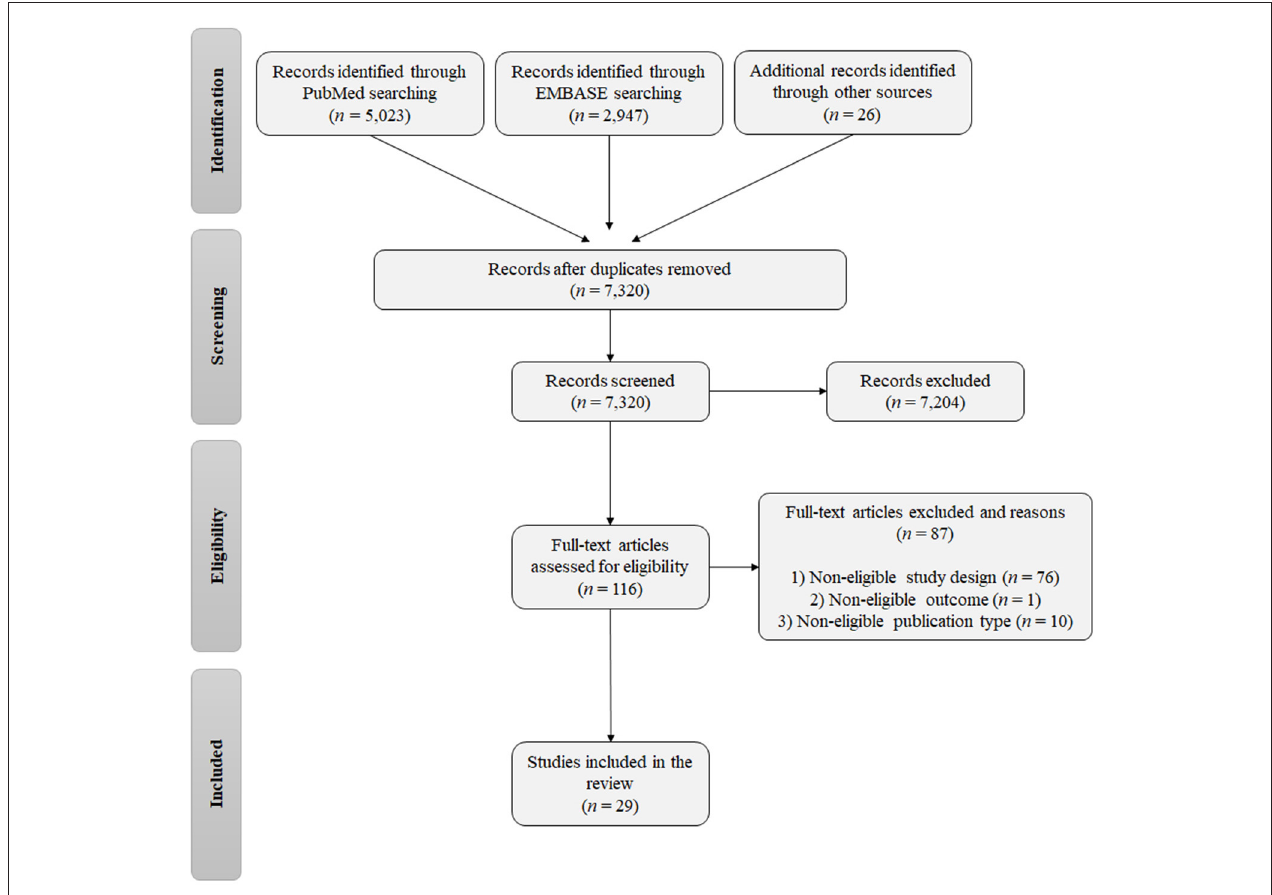
FIGURE 1 | Flowchart of the study screening and selection